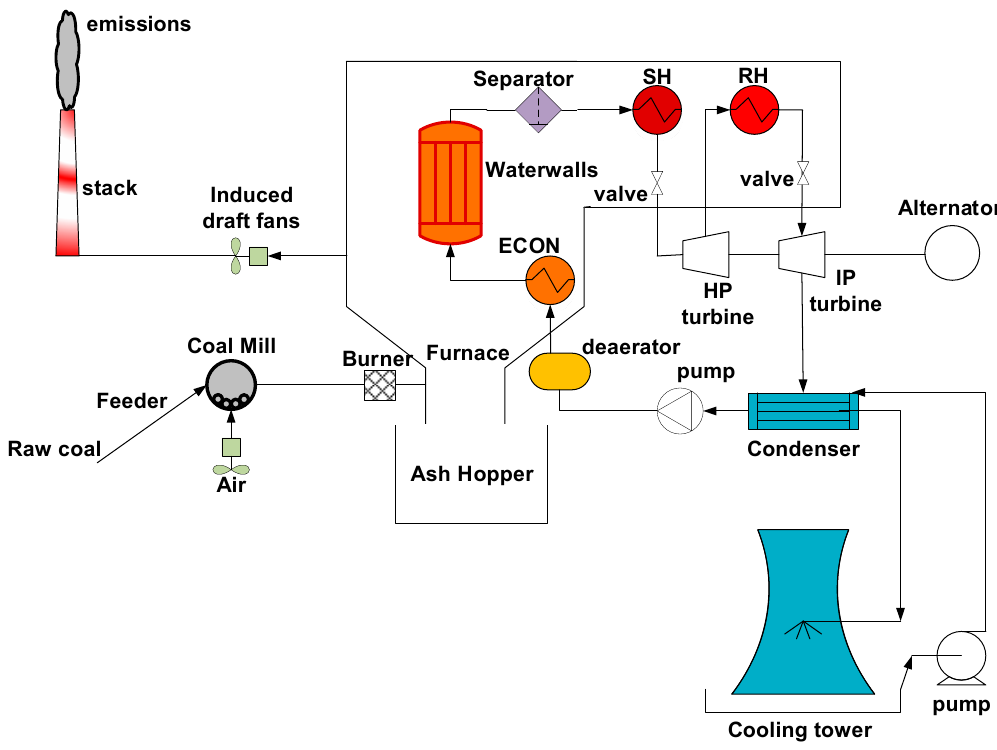
Figure 2. Coal-fired SCPP schematic view.